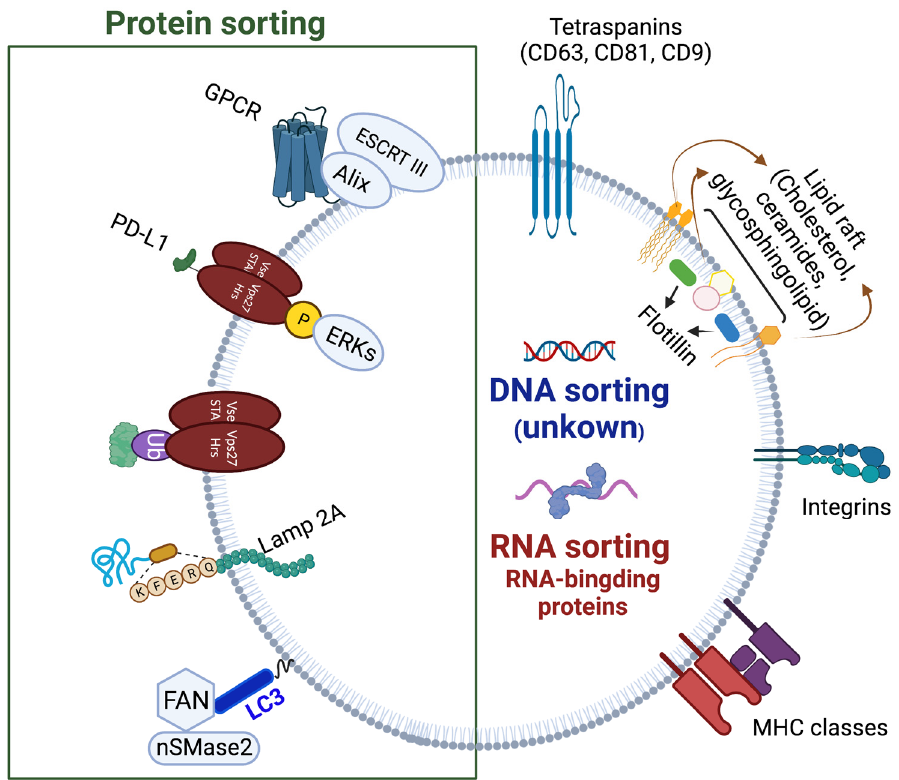
Figure 3. Cargo sorting into exosomes. The known pathways of protein, RNA, and DNA sorting are depicted. Exosomal membrane proteins including tetraspanins, flotillin, integrins, MHCs, and ESCRT are labeled. Created with BioRender.com.